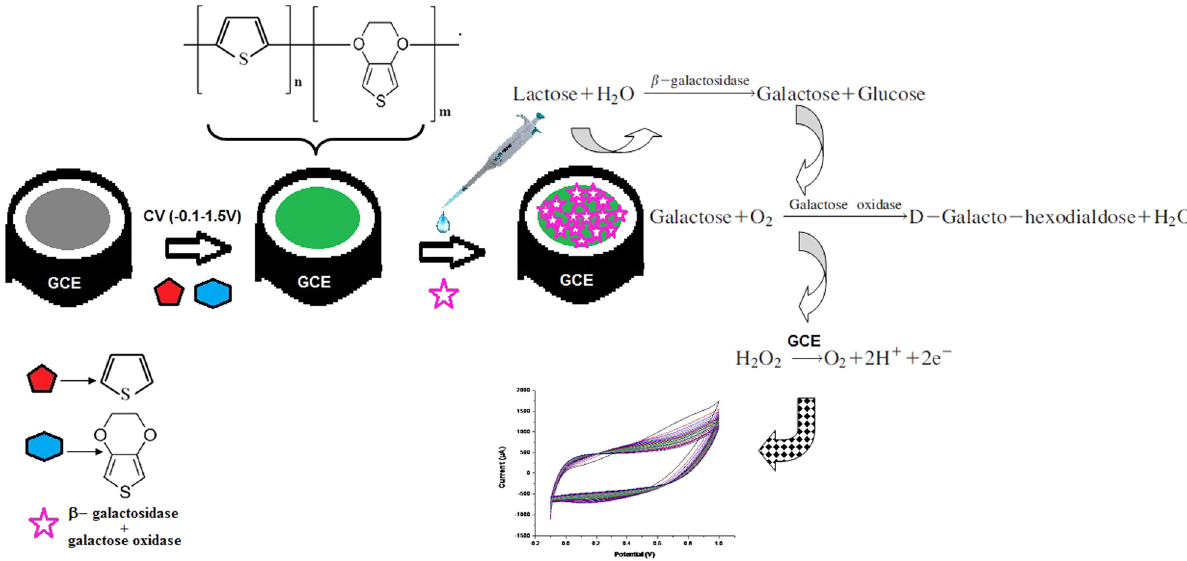
Figure 1: Copolymerization of EDOT/Th and working mechanism of the enzyme